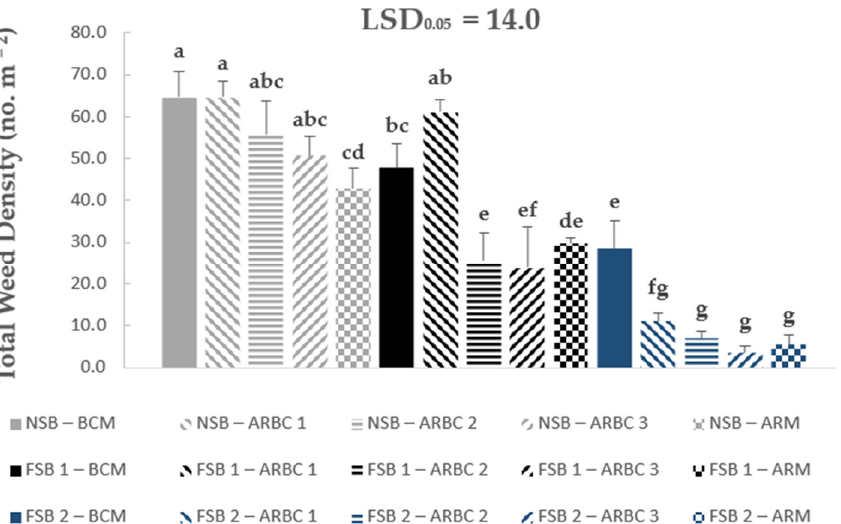
Figure 3. Total weed density (no. m − 2 ) in 2021–2022 (“no.” is the abbreviation of “number”). Data refer to the interaction between seedbed (S) and forage (F) factors. NSB: Normal seedbed, FSB 1: First false seedbed, FSB 2: Second false seedbed, BCM: Berseem clover monoculture, ARBC 1: First intercrop with annual ryegrass and berseem clover in a 25:75 ratio, ARBC 2: Second intercrop with annual ryegrass and berseem clover in a 50:50 ratio, ARBC 3: Third intercrop with annual ryegrass and berseem clover in a 75:25 ratio, ARM: Annual ryegrass monoculture (see text in Section 2.2 for details on abbreviations). Numbers followed by the same letter are not significantly different. Vertical bars indicate standard